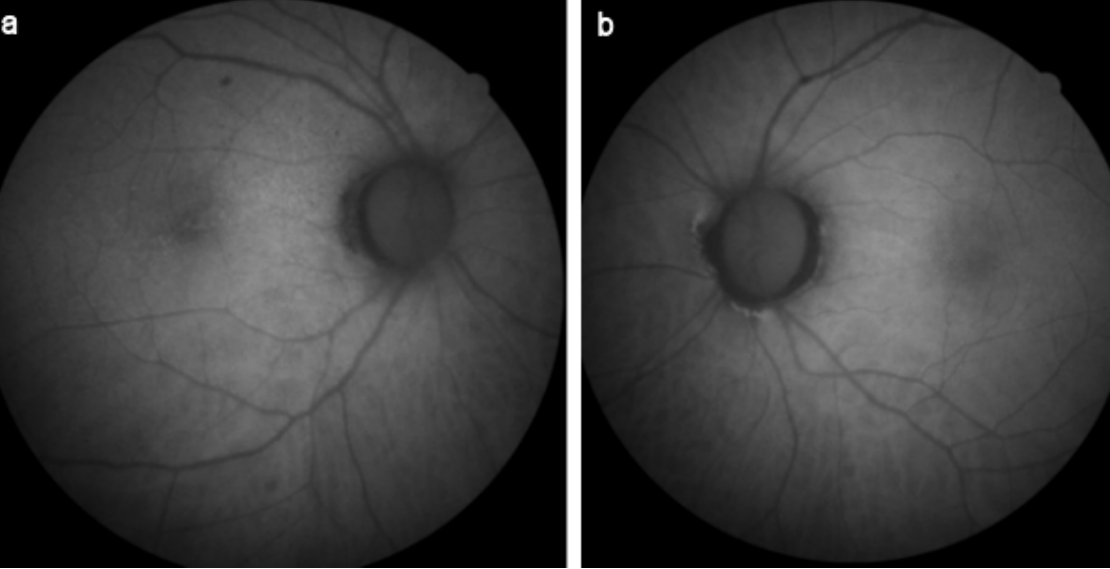
Figure 7: FAF images at 2-week examination after the treatment (a) FAF image of the right eye, (b) FAF image of the left